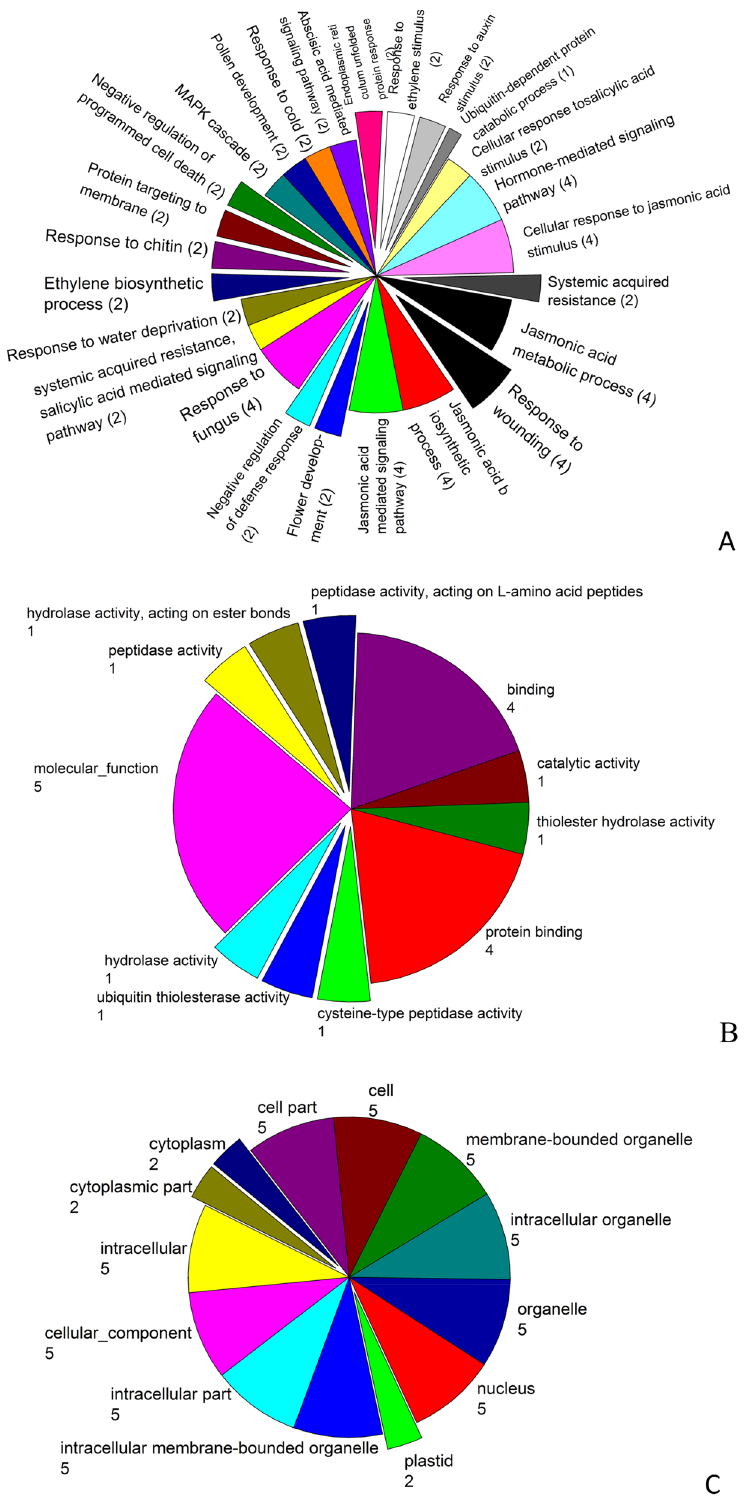
Figure 4. Gene Ontology term enrichment analysis of TaTIFY genes, ( A ) biological processes, ( B ) molecular function and ( C ) cellular